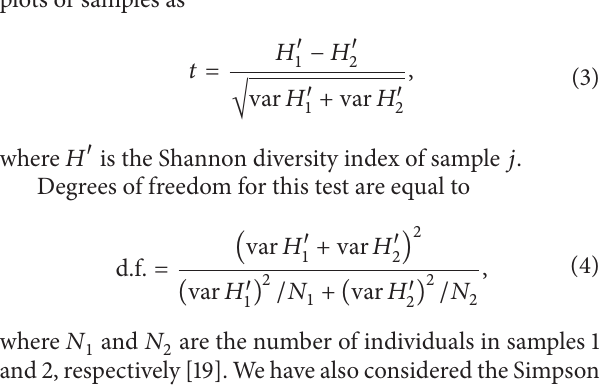
Figure 2: Ombrothermic diagram of Likouala (data from 1932 to 2015), ANAC Congo.